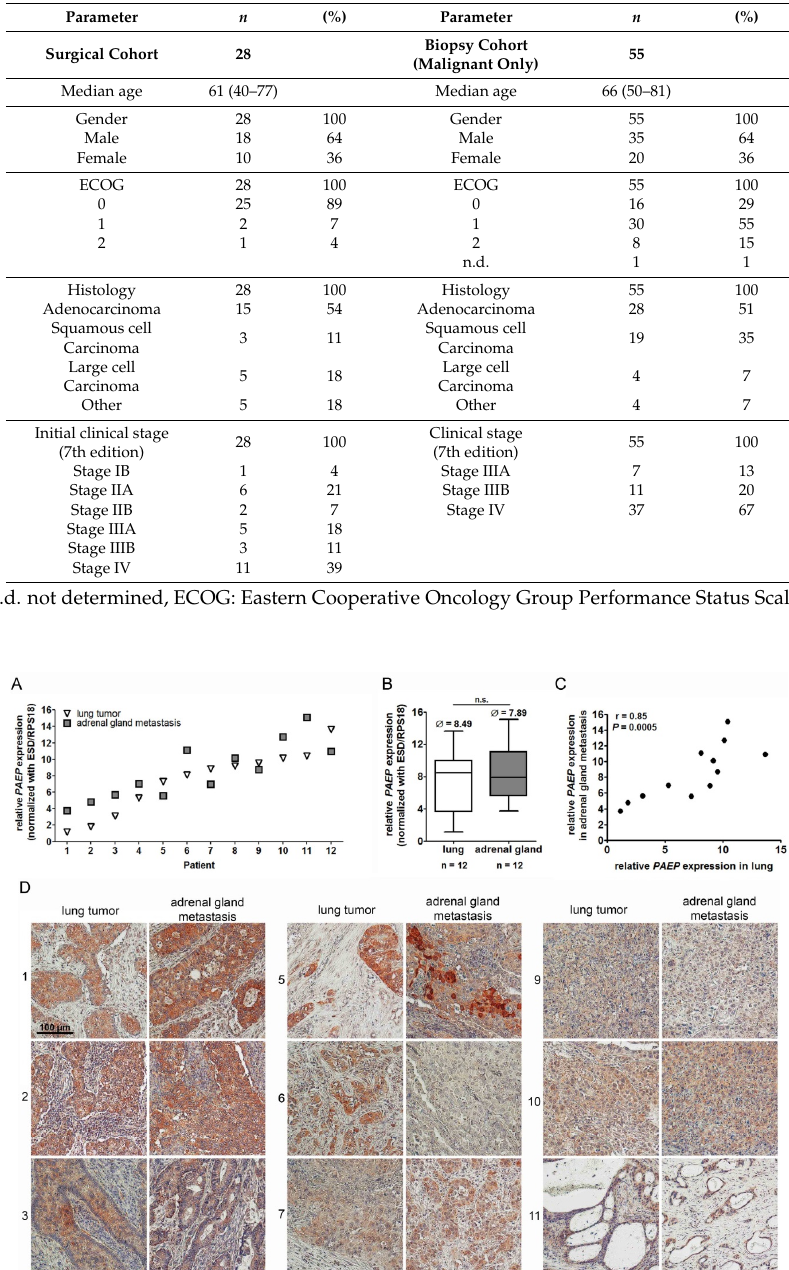
Table 1. Cohort characteristics.